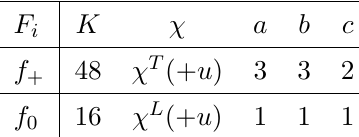
Table 3 . Inputs entering (cid:30) i ( t ; t 0 ) in eq. (5.8) for the meson form factors F i